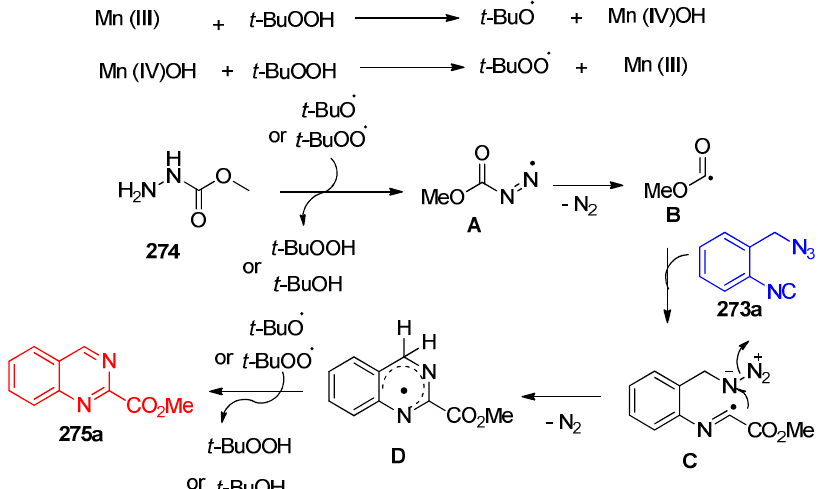
Scheme 110. Proposed mechanism for the formation of quinazoline 275a via the radical pathway.